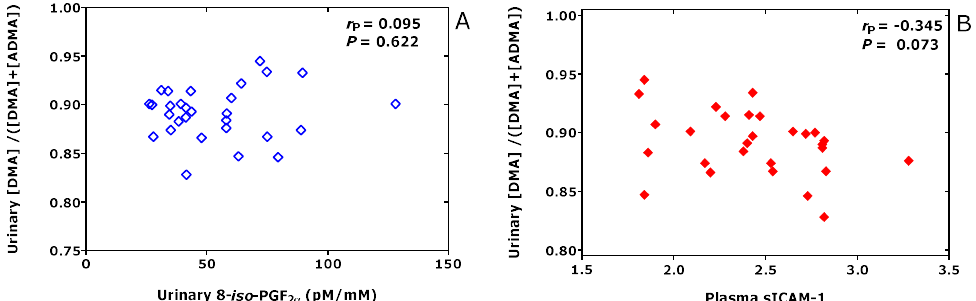
Figure 10. Pearson correlations between the whole-body DDAH activity, i.e., dimethylamine (DMA) / (DMA + ADMA), and the creatinine-corrected excretion rate or the oxidative stress biomarker 8- iso -prostaglandinF 2 α (8- iso -PGF 2 α )( A ) or plasma soluble intracellular adhesion molecule-1 (sICAM-1) ( B ) in healthy overweight men.